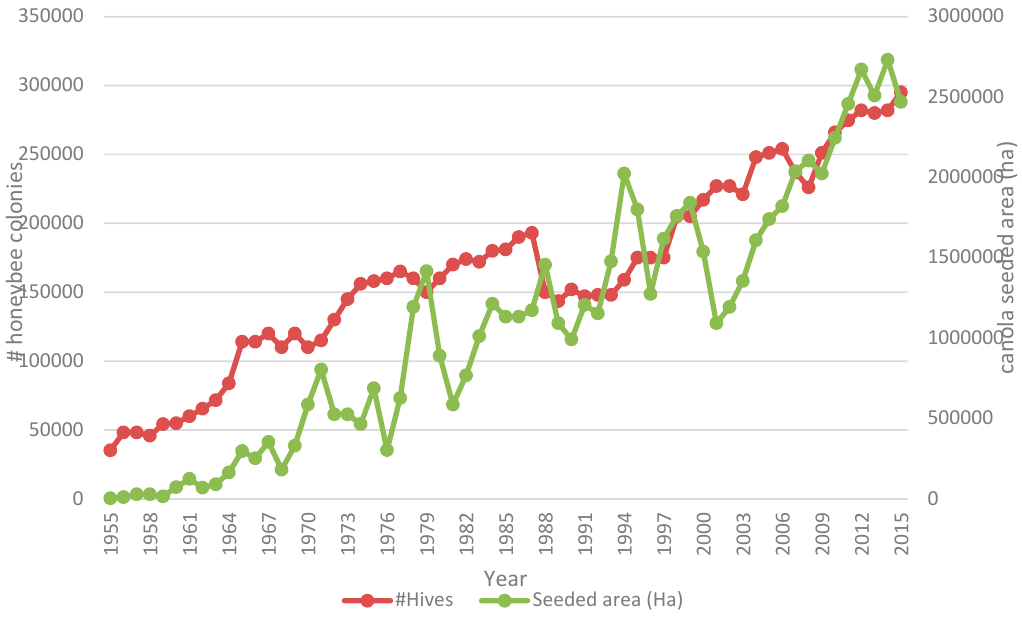
Figure 1. Historical canola planted acres and managed honeybee hives in Canada (1995–2015).